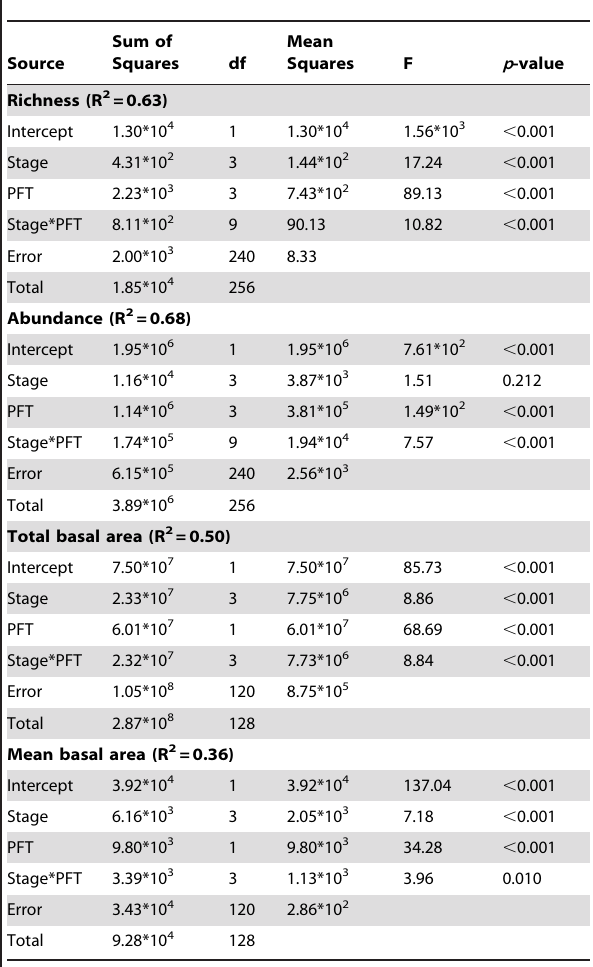
Table 4. Two-way ANOVAs of the effects of PFTs, successional stages after PWD, and their interaction on the four metrics of plant community